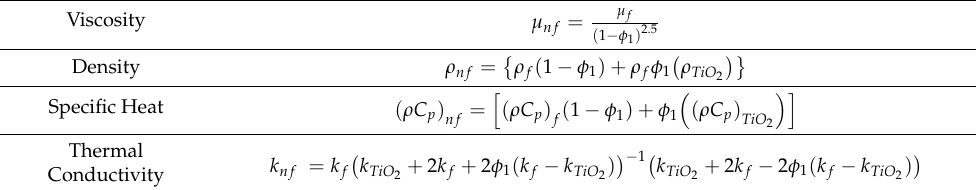
Table 1. Thermophysical properties of TiO 2 − Blood nanofluid [3,18].